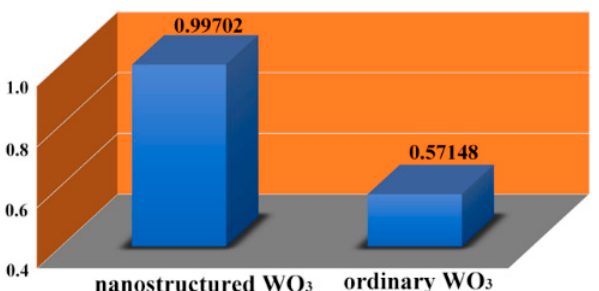
Figure 8. Adhesion of the nanostructured WO 3 film and the ordinary WO 3 film.